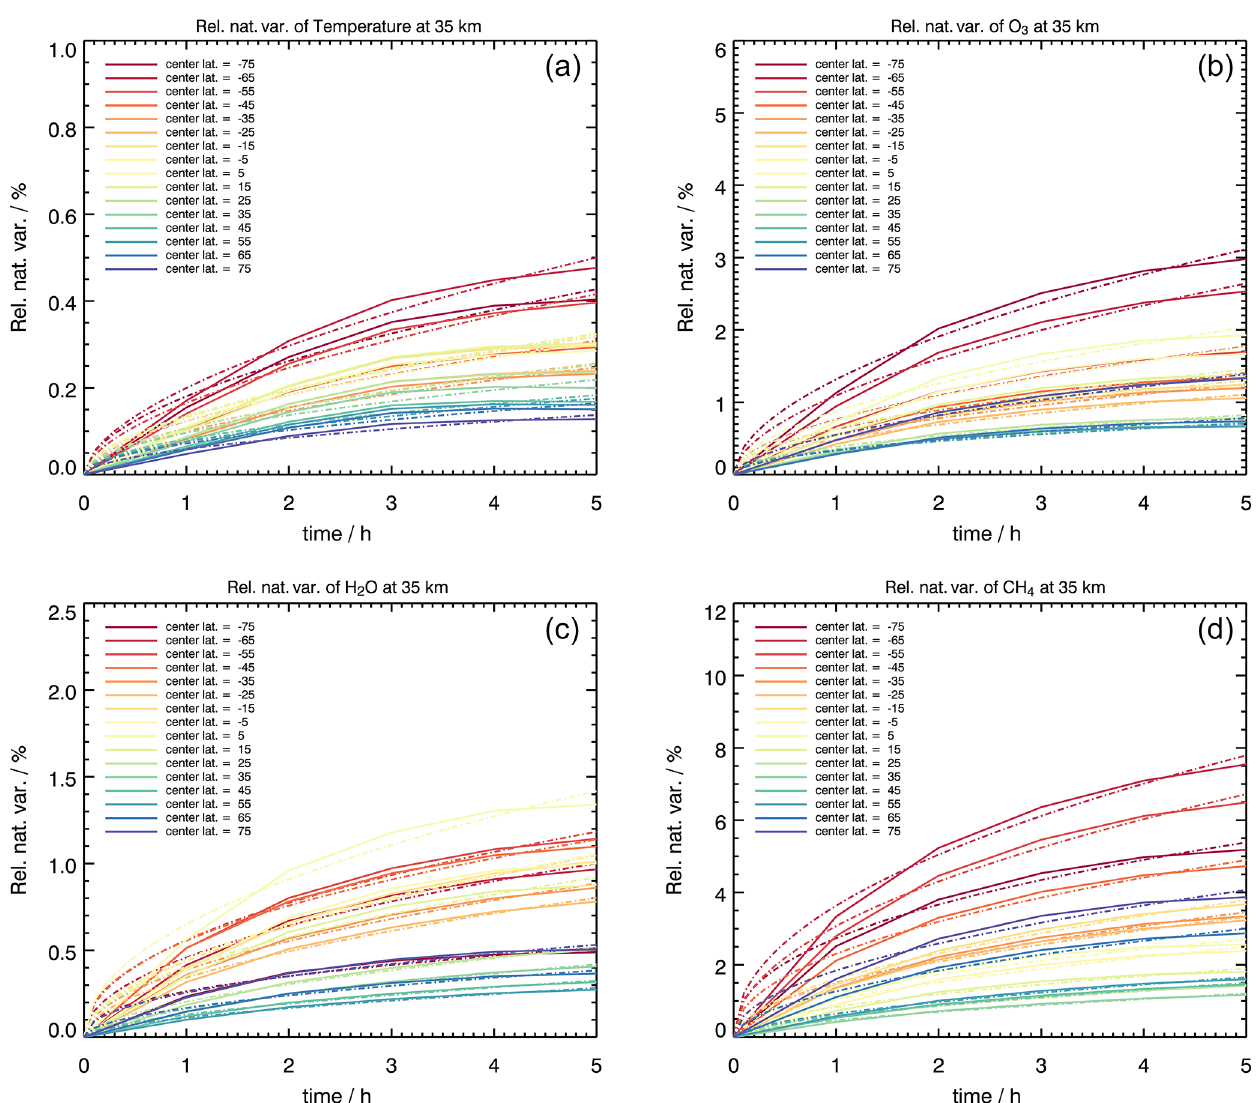
Figure 3. Natural variability as a function of time separation for (a) temperature, (b) O 3 , (c) H 2 O and (d) CH 4 in the BASCOE model (solid lines) and the proposed parametrization (dashed lines) in different latitude bins.